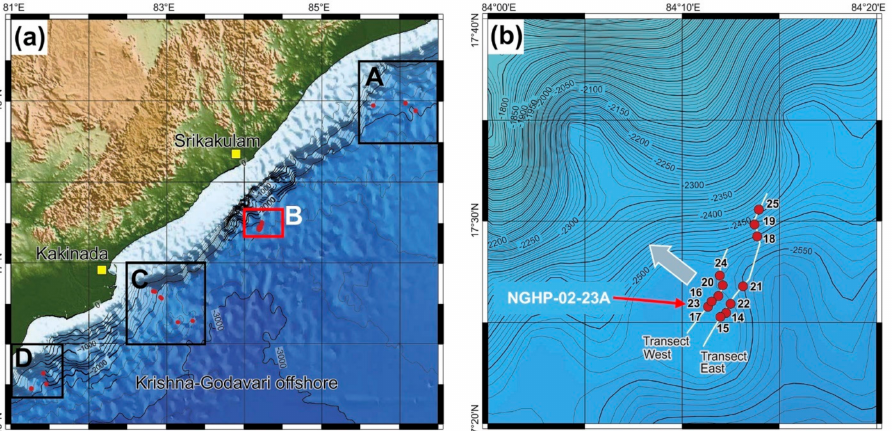
Figure 1. The study area ( a ) with drill sites in Areas A, B, C and D in the Krishna-Godavari Basin offshore eastern India. ( b ) Zoomed location of Area B with twelve sites drilled for LWD and five sites (NGHP-02-16, -17, -19, -22 and -23) for coring operations during the NGHP-02. The grey arrow indicates the upward direction of the crest of the anticline in Area-B. The red arrow indicates NGHP-02-23A in the West Transect, from which the data was used in this study. Modified after [29]. The other well, U1517A, was drilled in 2017 by the IODP drillship “JOIDES Resolution” during IODP Expedition 372A Creeping Gas Hydrate Slides at the Hikurangi margin, Tuaheni Landslide Complex, New Zealand [22], shown in Figure 2.